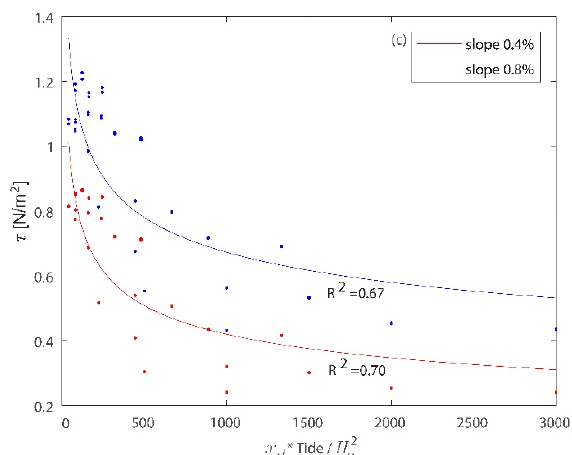
Figure 5. Shear stress as function of the x distance for the x d = 100 m configuration. ( a ) Shear stress focus on the peak due to the presence of the breakwater (same reading key of Plot 2a). ( b ) Shear stress zoom on the marsh zone (same reading key of Plot 2a). ( c ) Shear stress value at the beginning of the marsh ( x = 200 m) for the two different slopes, as functions of the dimensionless variable x d *Tide/ H s 2.